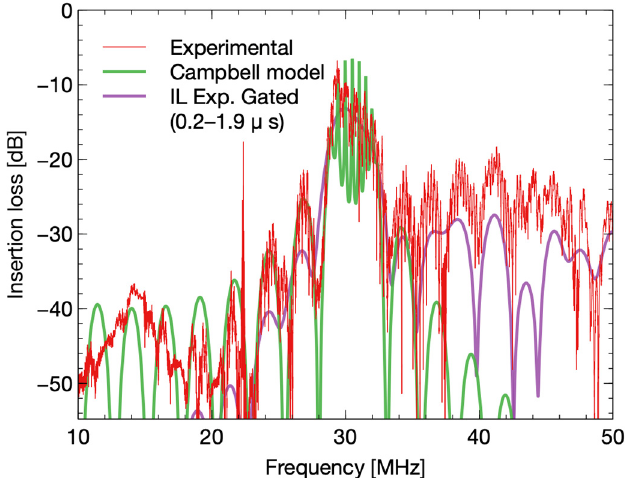
Figure 8. IDT response (green) of the Campbell model of a 30 MHz device on a LiNbO 3 36Y-X substrate, with symmetric 12 simple finger IDTs, and 29 λ as a delay path. The red curve corresponds to the experimental response of the sensor on air. In purple is the experimental response with a gating filter, with a temporal window from 0.2 µs to 1.9 µs.